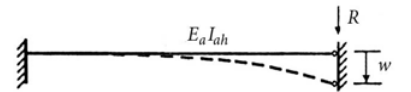
Fig. 7. Clamped/pinned beam under concentrated load at pinned